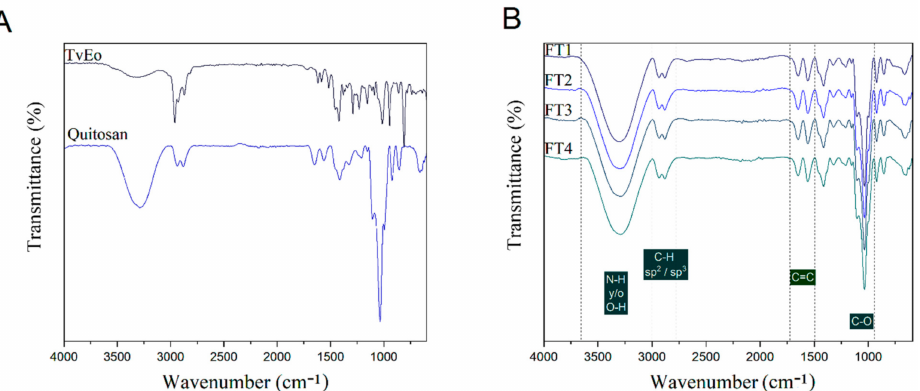
Figure 8. FT-IR spectra of TvEO and films made with pure chitosan ( A ) and comparative stacking of the four hybrid films containing different concentrations of TvEO ( B